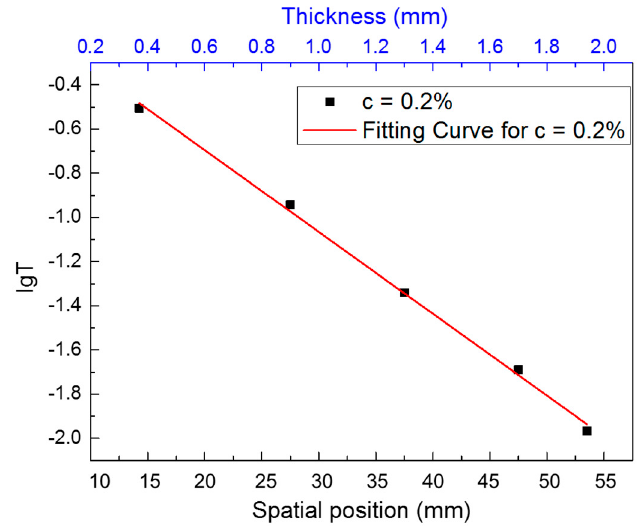
Figure 5. Characterization of transmittance versus sample thickness.